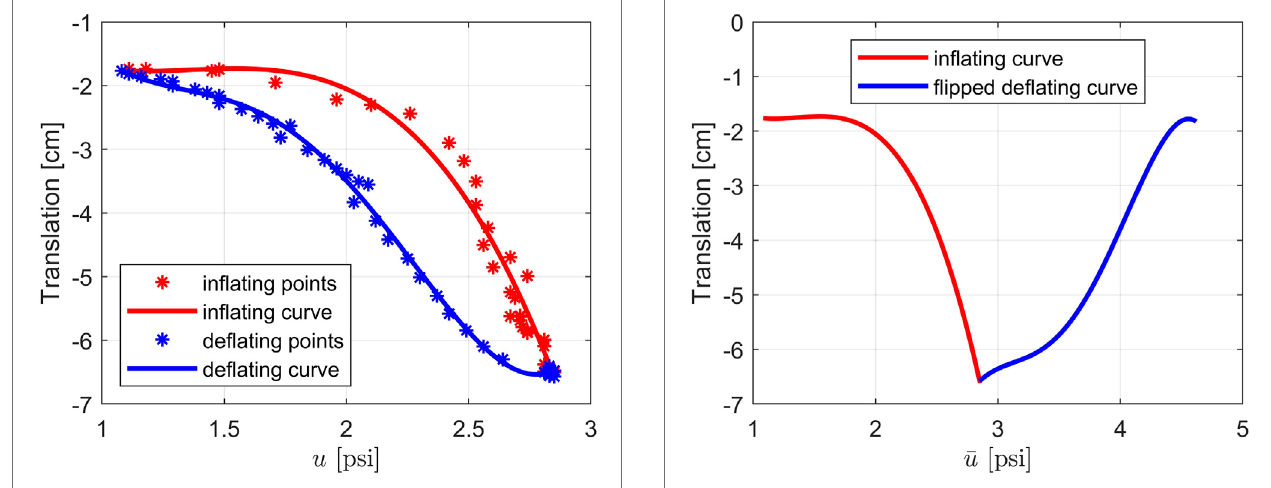
FIGURE 4 | The new hysteresis curves describing the translation of the tip of the soft robot in Y direction with respect to (cid:2) u